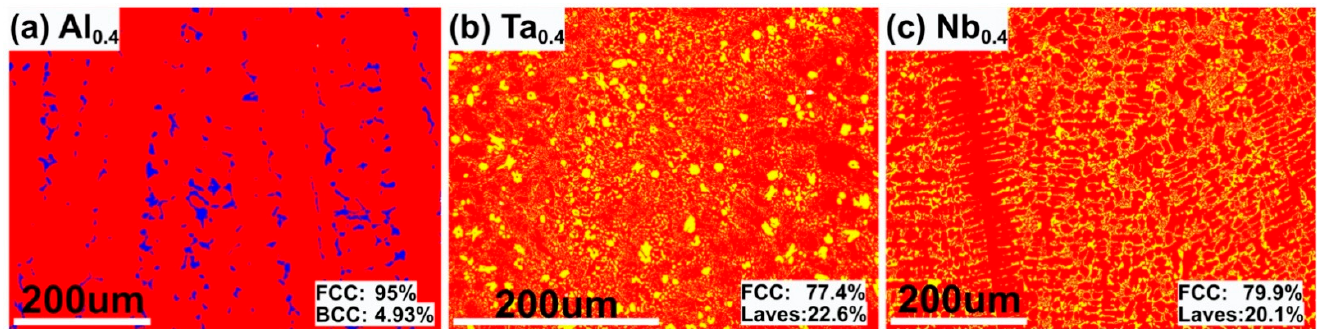
Figure 6. The phase distribution of the ( a ) CoCrFeNiAl 0.4 , ( b ) CoCrFeNiTa 0.4 , and ( c ) CoCrFeNiNb 0.4 HEAs prepared by PPA-AM.